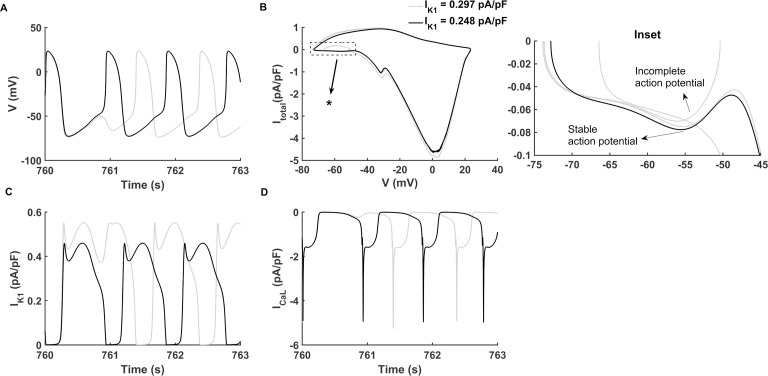
Persistent pacemaking activity.The current densities of (IK1, If) of stable pacemaking activity and periodically incomplete pacemaking activity are at (0.248 pA/pF, -3.15 pA/pF) (‘CASE 4’, black lines) and (0.297 pA/pF, -3.15 pA/pF) (‘CASE 3’, grey lines) respectively. (A-D) The membrane potential (V), phase portraits of membrane potential against the total membrane channel current (Itotal), inward rectifier potassium channel current (IK1) and L-type calcium channel current (ICaL) during the simulating time course of 760–763 s. (Inset) Expanded plot during V from -75 to -45 mV and Itotal from -0.1 to 0 pA/pF marked by the asterisk in (B).